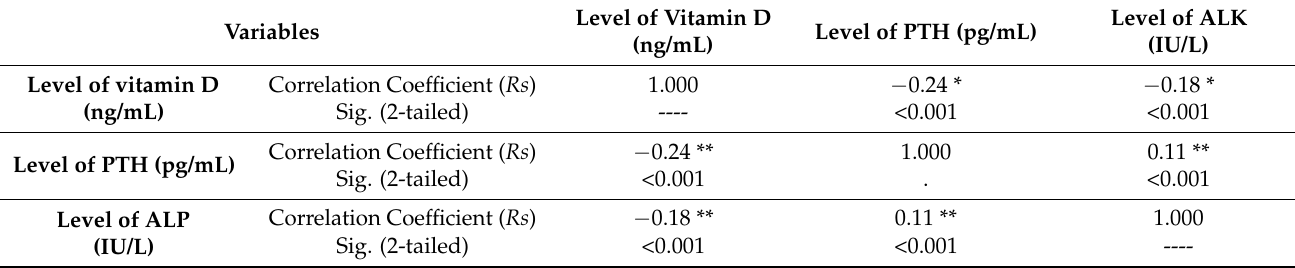
Table 5. Correlation between vitamin D and PTH and ALK (n =